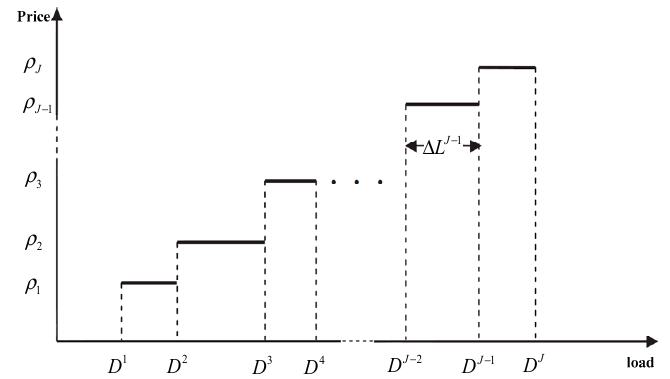
Figure 2. Gradual price and demand curve for Demand Response (DR).